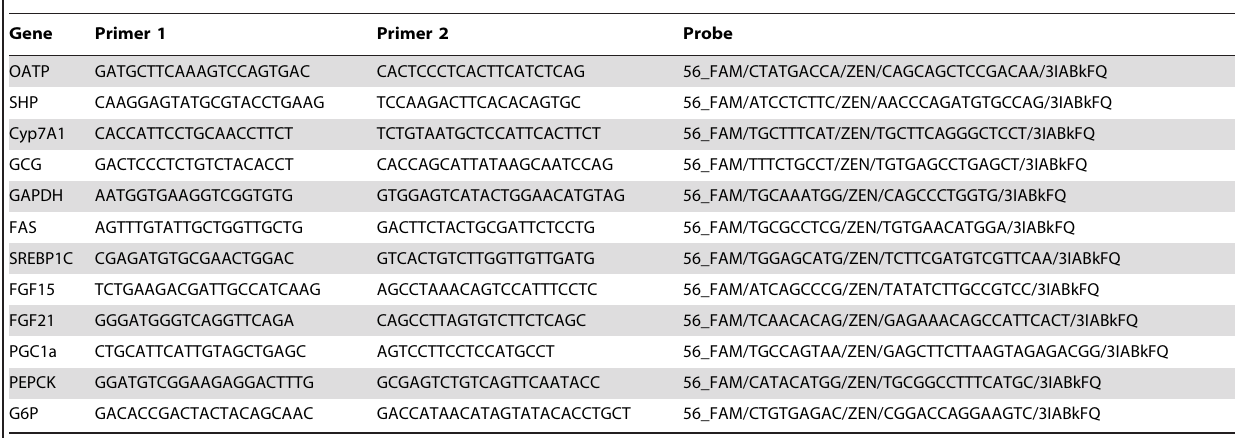
Table 1. Sequences of primers and probes used for real-time PCR.